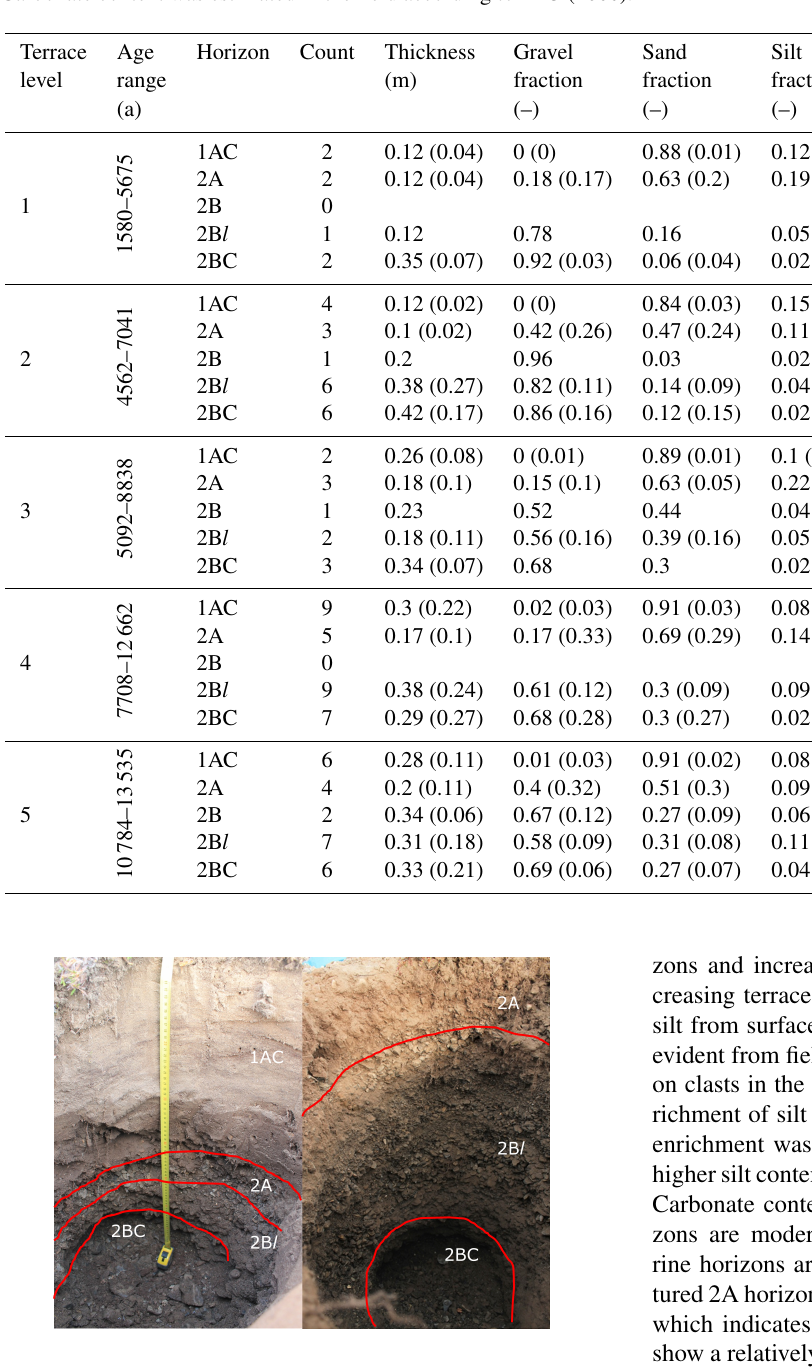
Figure 4. Examples of a typical soil found on a trough (left panel) and ridge location (right panel). The prefixed numbers indicate the parent material: aeolian (1) or marine